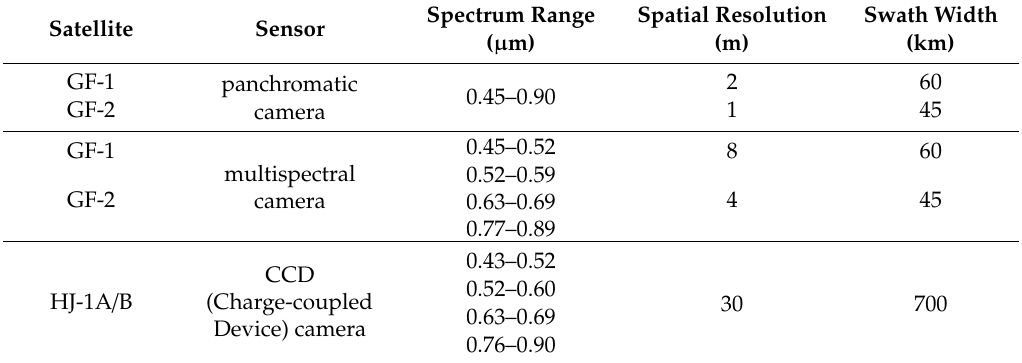
Table 1. Main payload parameters of GF-1 / 2 and HJ ((Huangjing, which means environment in Chinese))-1A / B.